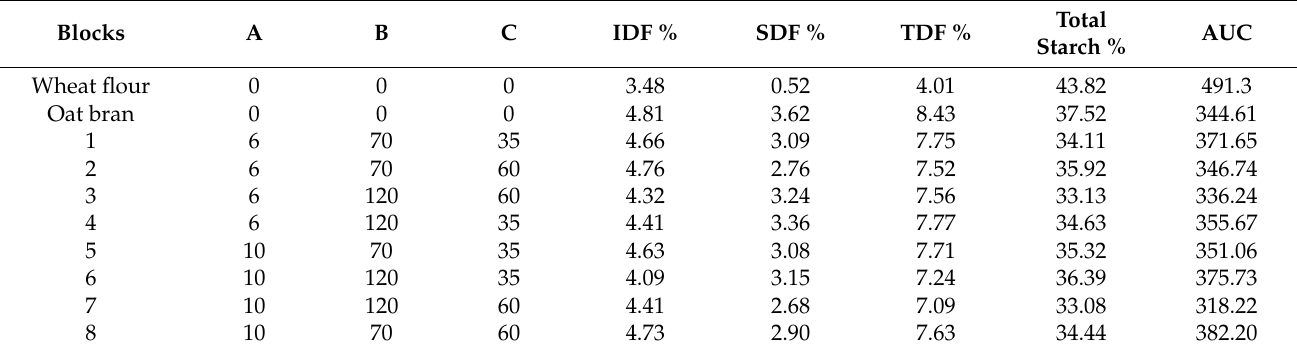
Table 3. Effect of enzymes combination on the chemical properties of